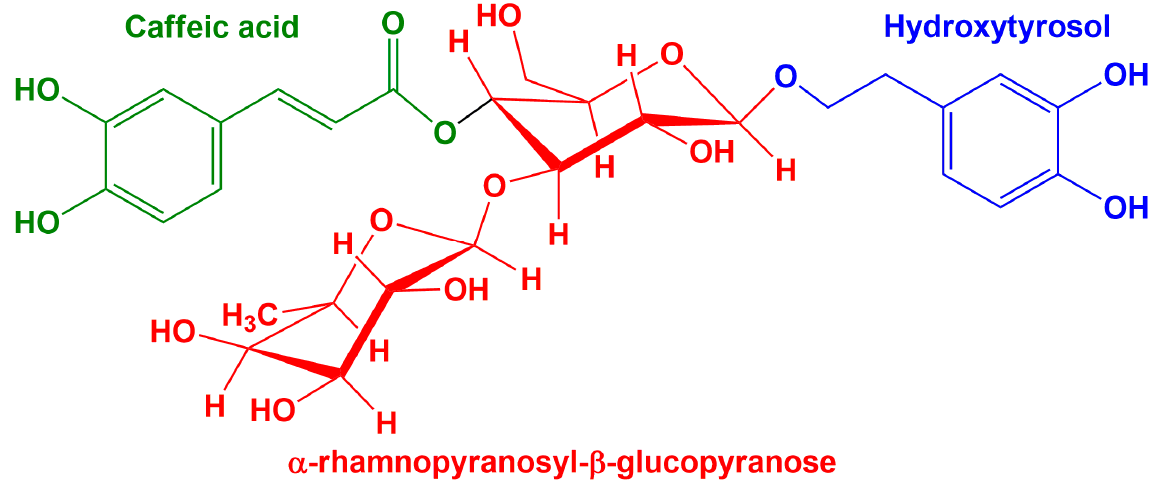
Figure 1. The chemical structure of verbascoside glycoside.